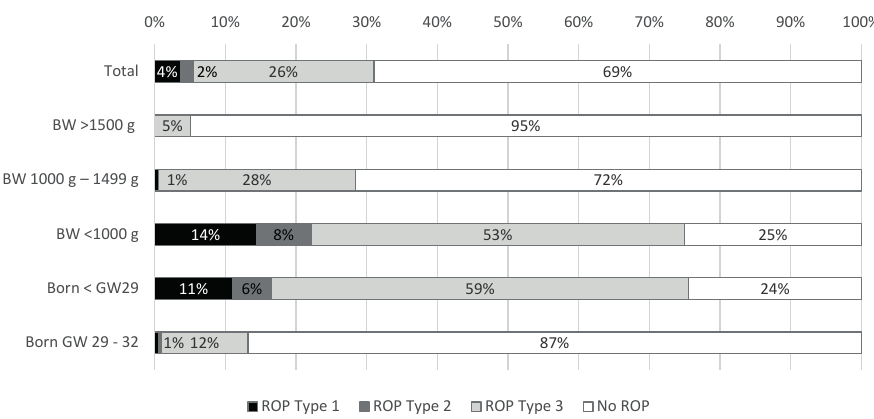
Fig. 1. Distribution of prematurely born infants throughout the entire study group and in subgroups according to the presence and type of